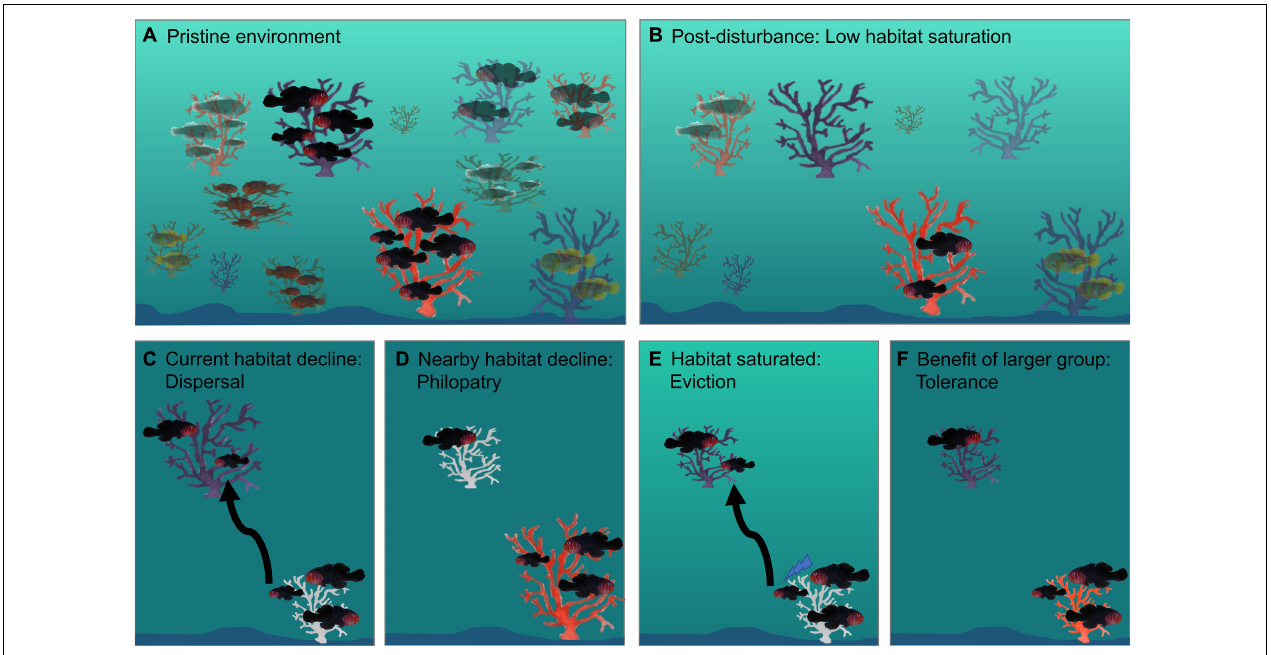
FIGURE 7 | Possible effects of environmental disturbances on the sociality of reef fishes, using Gobiodon with Acropora coral hosts as examples. After disturbances, a pristine environment (A) can become less saturated if fish populations decline more than their habitat (B) . If habitat declines (i.e., smaller and unhealthy corals) influence subordinates’ payoffs to stay or leave, then current coral patch quality (C) and nearby coral patch quality (D) will affect the subordinates’ decisions to stay or leave. If habitat declines influence payoffs of dominants tolerating subordinates, then subordinates in smaller patches will either be evicted (E) or be tolerated because of synergistic effects (F)